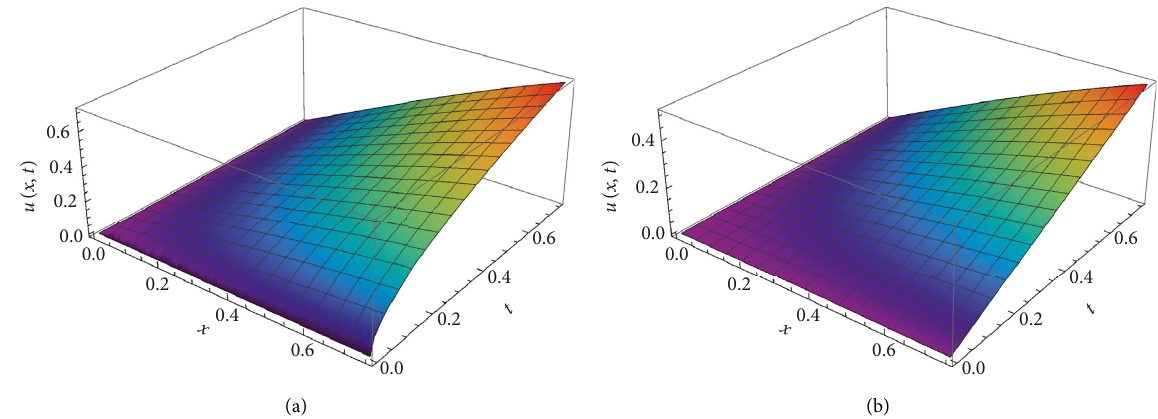
Figure 8: The graphs of the third-order approximate iterative solution u ( x, t ) for (30) through various values of x,t at α � 0 . 5 , 1, re- spectively. (a) The graph of the approximate iterative solution u ( x, t ) for (30) through various values of x,t at α � 0 . 5. (b) The graph of the approximate iterative solution u ( x, t ) for (30) through various values of x, t at α � 1.